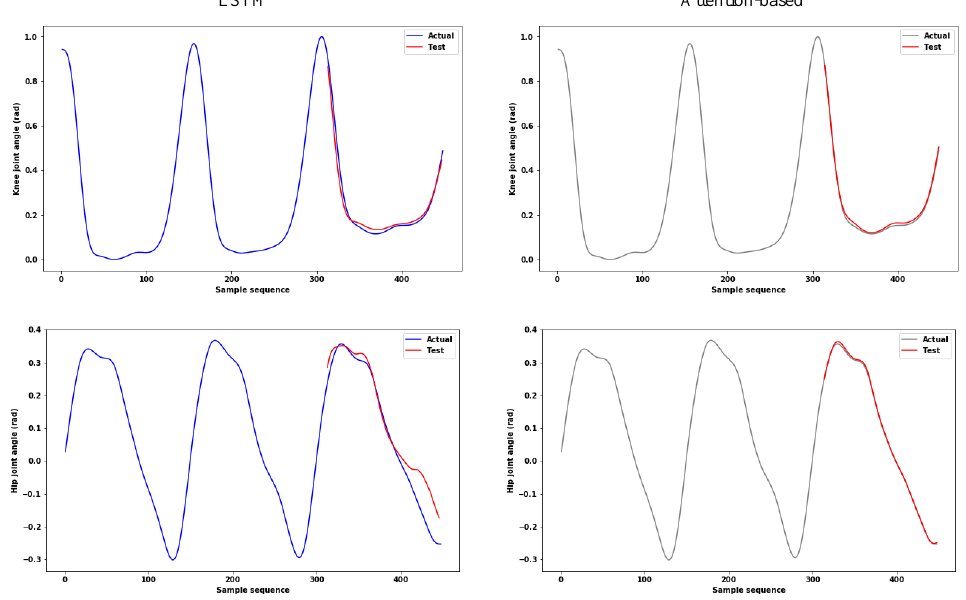
Figure 6. Gait trajectory prediction results on real datasets from subject 1.